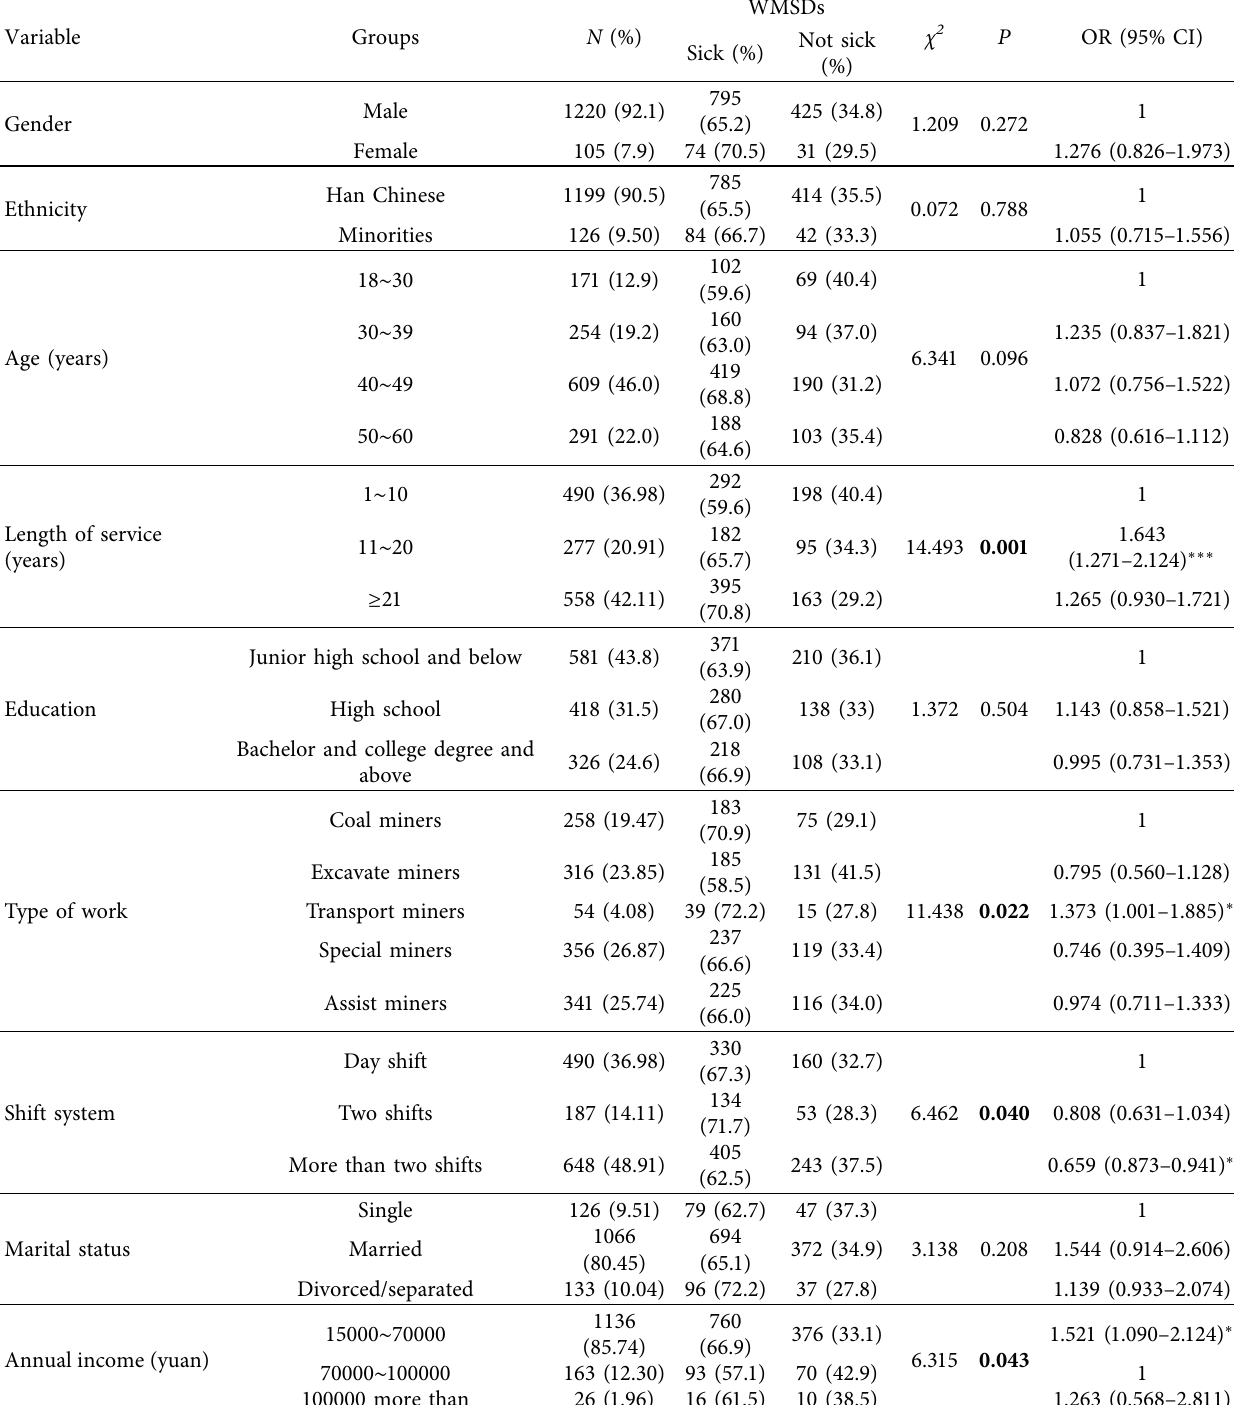
Table 1: The relationship between individual factors and